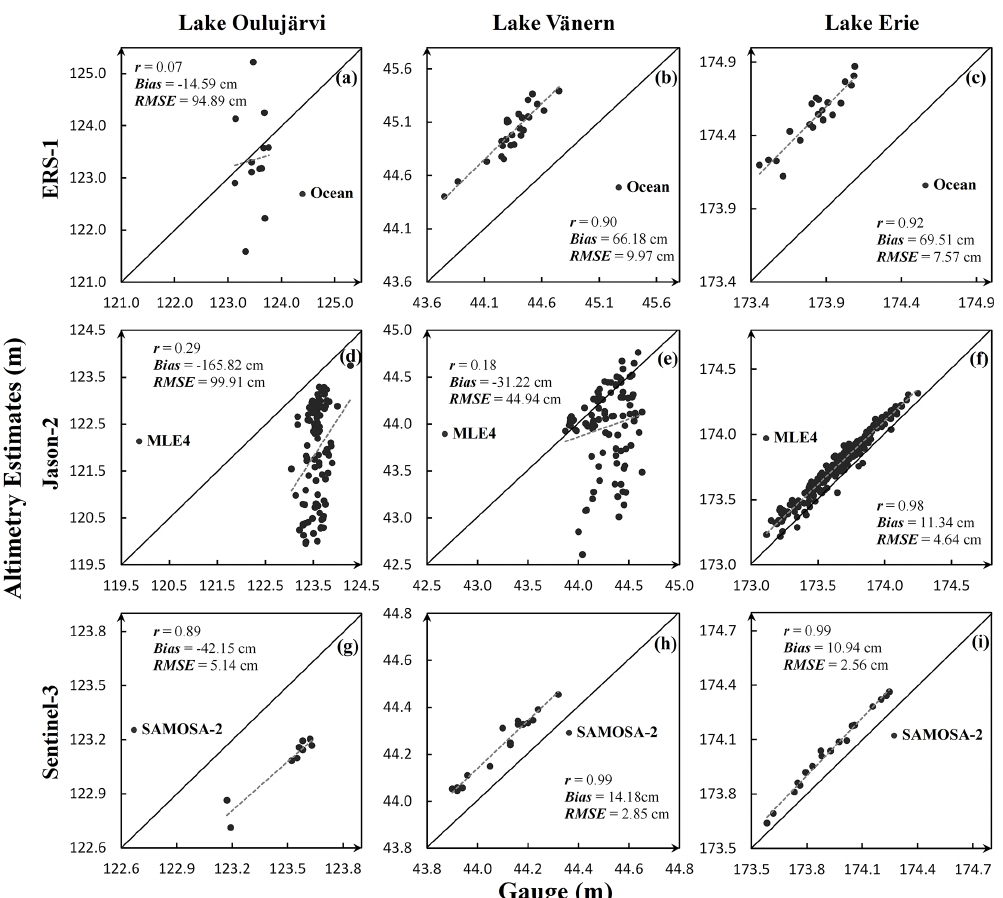
Figure 6. Scatterplots of lake water level estimates given by model-based retrackers against gauge measurements. The scatterplots of the same mission are arranged in the row, and the scatterplots of the same lake are arranged in the